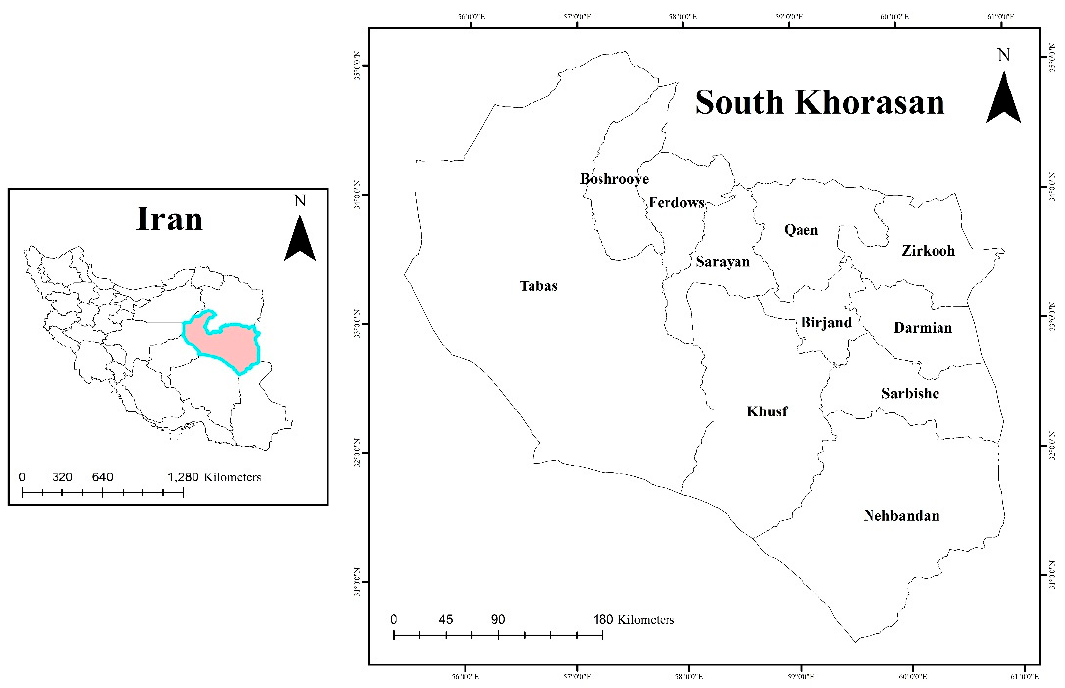
Figure 1. Map of the study area, South Khorasan and its 11 counties.